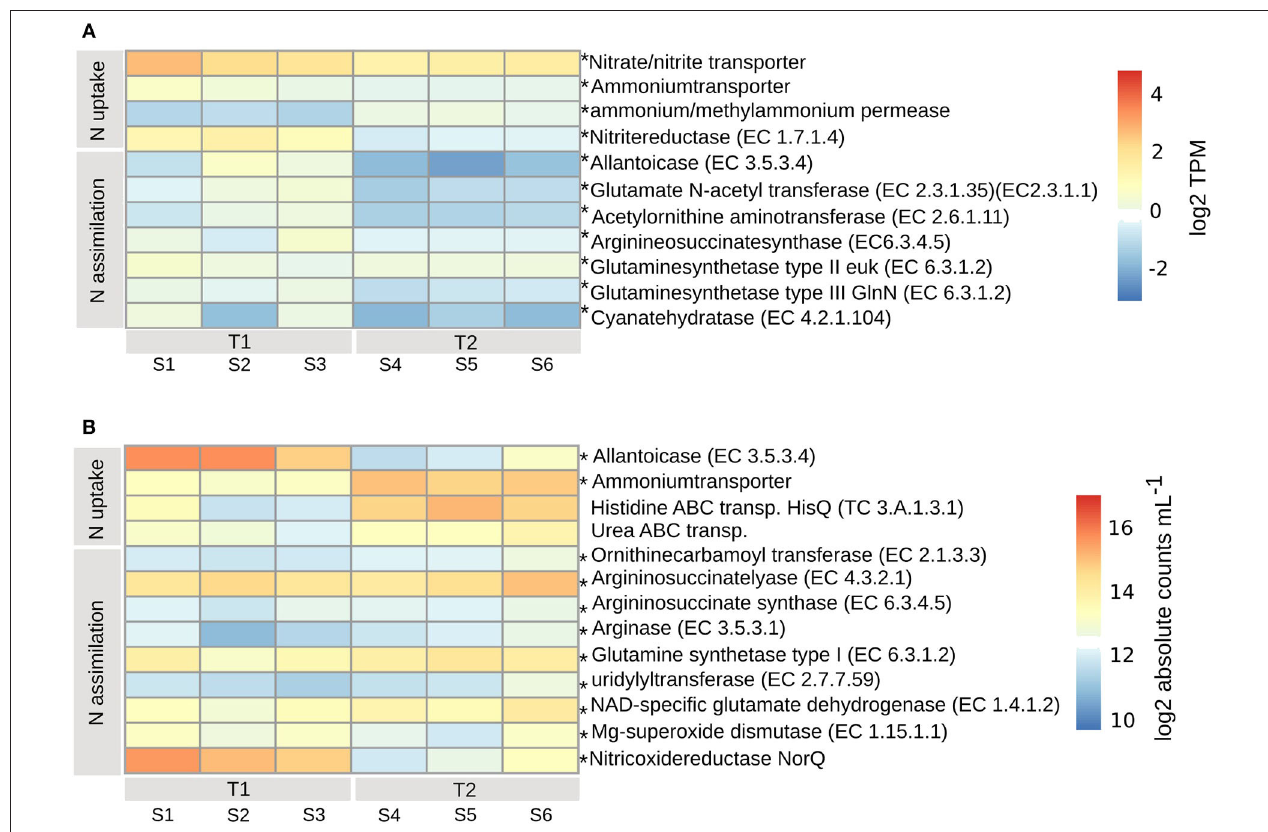
FIGURE 5 | Transcripts involved in nitrogen uptake and assimilation for PE (A) and BAC (B) , calculated according to legend in Figure 4 . Asterisks indicate enzymes that were significantly changed from T1 to T2 (adjusted p < 0.01). T1, first timepoint (samples S1–S3); T2, second timepoint (samples S4–S6); N uptake , uptake of nitrogen; N assimilation , nitrogen